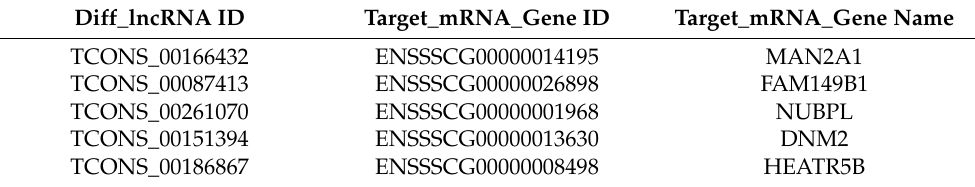
Table 2. Target gene prediction of partial differential lncRNAs